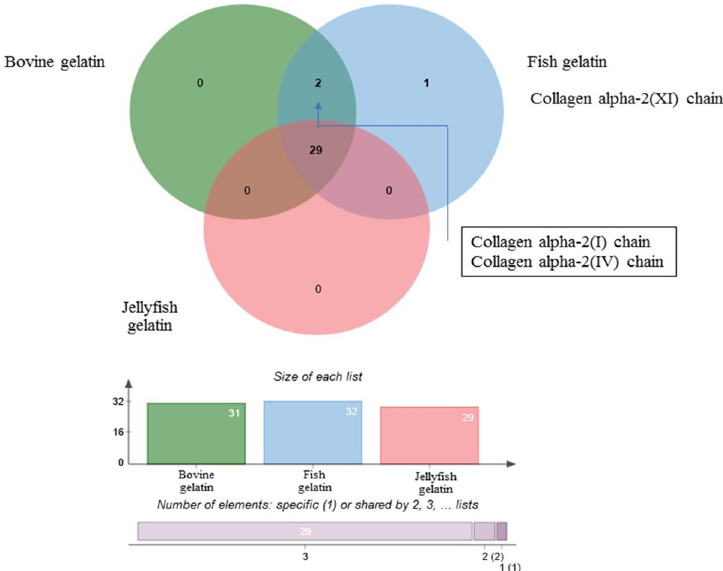
Fig 4. Proteins in jellyfish, fish and bovine gelatin identified by LC-MS/MS. A Venn diagram showing the total number of proteins identified in each gelatin sample.